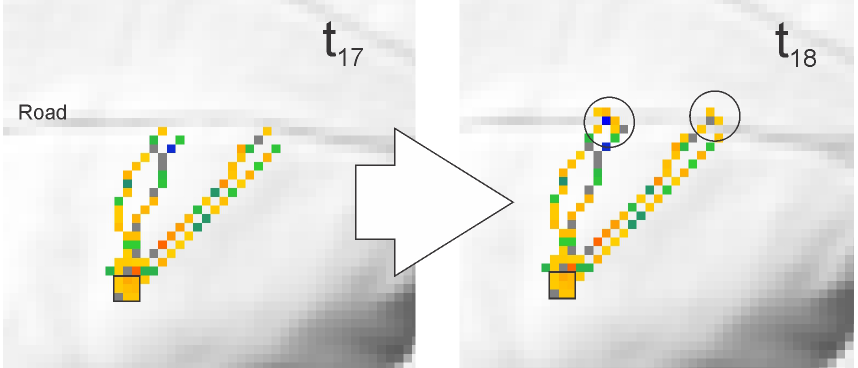
Figure 2. Agent spawning (inside circles) due to a topographic change at a road that is reached in time step 18. Landslide is traveling NE (to upper right corner), and the initiation zone is the 15 × 15m square outlined in